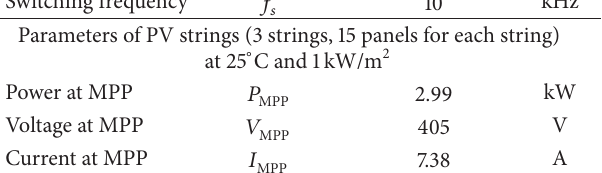
shown in Figure 5. th (𝑗 - 𝑐)